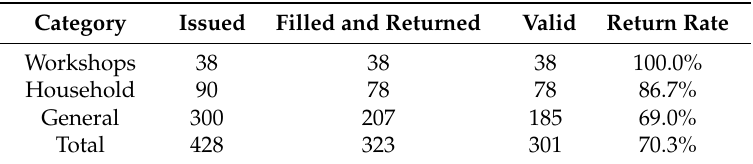
Table 2. Questionnaire return rate (%).